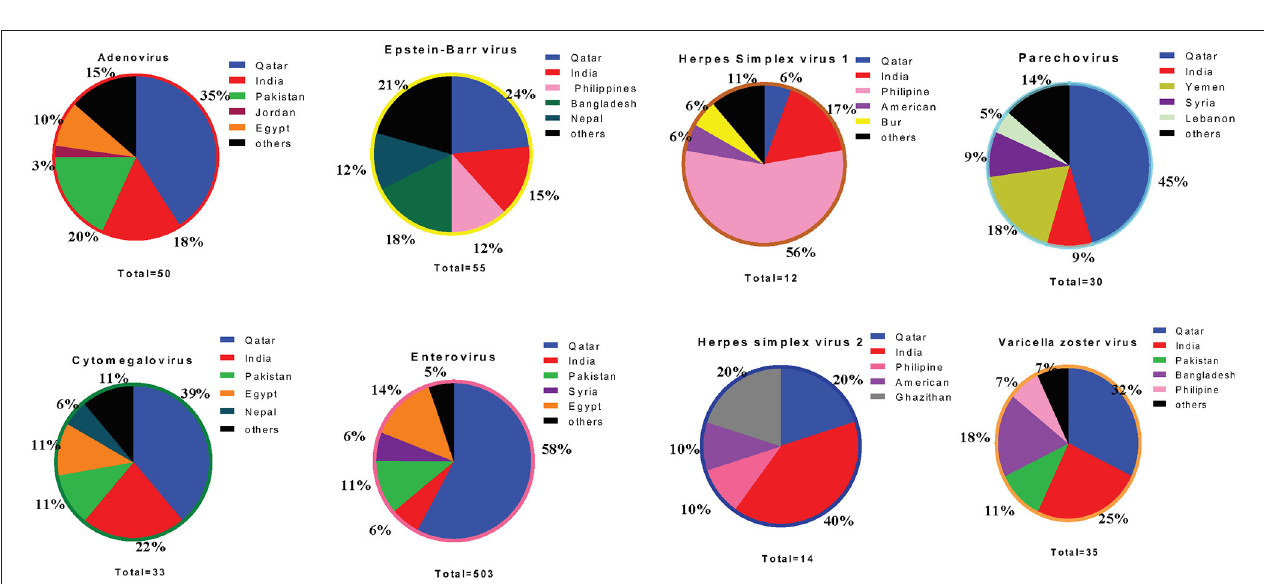
symptoms were observed only in two patients positive for EV (0.27%, 2/732) ( Figure 5